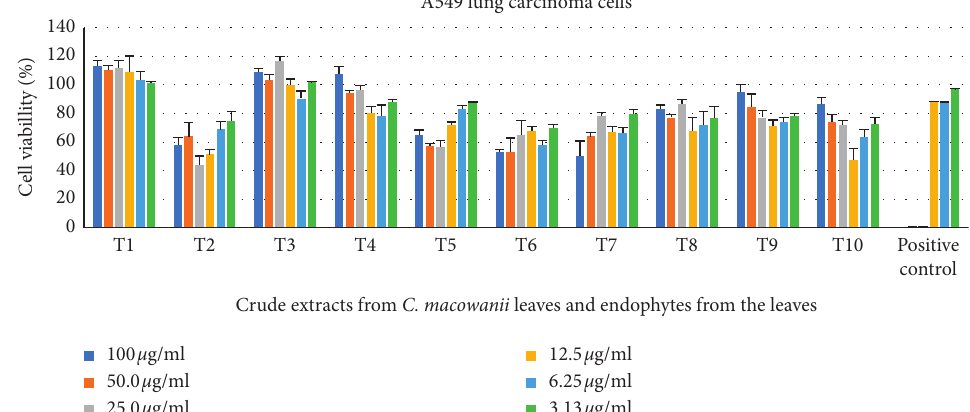
Figure 2: Cytotoxic activity of endophytic-derived secondary metabolites and crude extracts on A549 lung carcinoma cells tested at different concentrations ranging from 100 to 3.13 μ g/mL. The positive control used was auranofin. T1 � C. macowanii leaves, T2 � Raoultella ornithinolytica , T3 � Acinetobacter guillouiae , T4 � Pseudomonas sp., T5 � Pseudomonas palleroniana , T6 � Pseudomonas putida , T7 � Bacillus safensis , T8 � Enterobacter asburiae , T9 � Pseudomonas cichorii, T10 � Arthrobacter pascens .